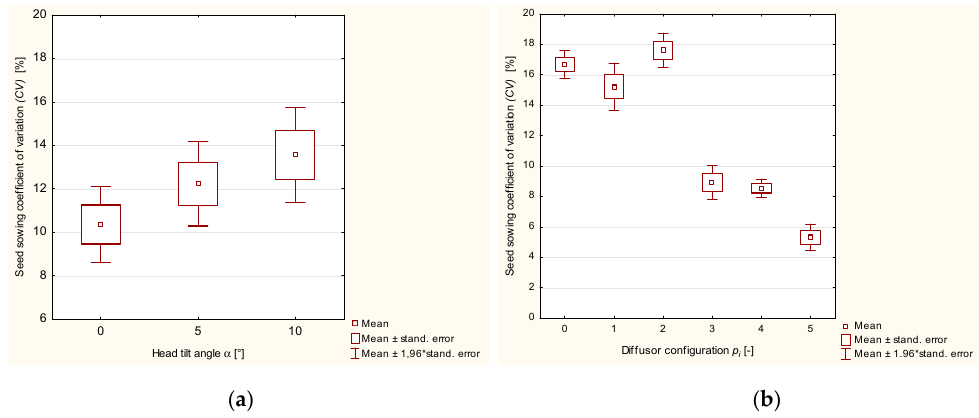
Figure 10. Variability of the coefficient of variation ( CV ) for oat seeds sowing evenness depending on: ( a ) the head tilt angle, ( b ) the diffuser variant (the configuration and number of diffusion rings). Table 2. The analysis of variance for the coefficient of variation ( CV ) in transverse rye seeds sowing evenness depending on the angle of the distribution head deviation from the vertical position α (°) and the diffuser variant p (the configuration and number of diffusion rings).